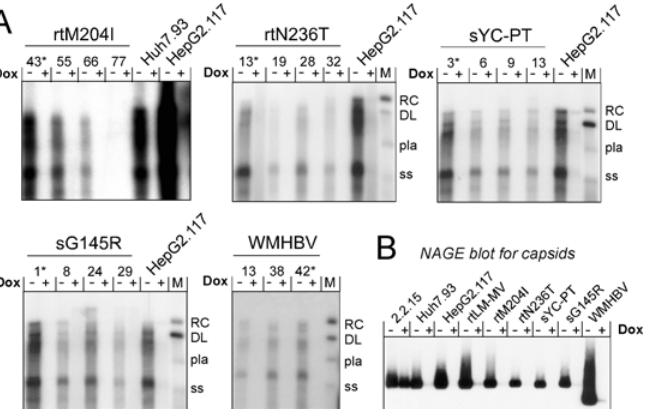
Fig 1. Generation of HepG2-based TetOFF cell lines producing variant HBVs and WMHBV. (A) Selection of well-performing cell clones. Clones preselected for the presence of HBV DNA were grown in the absence (-) or presence (+) of DOX. Intracellular capsid-associated viral DNA was analyzed by Southern blotting, using a 32 P labeled HBV specific probe. The wt-HBV producing Huh7.93 and HepG2.117 lines [44] served as reference. M, marker DNAs consisting of mixture of a 3.2 kb linear HBV genome in double- stranded (DL) and heat-denatured single-stranded (ss) form, plus a 3.2 kb plasmid (pla) including about 500 bp HBV sequence. RC, relaxed circular DNA. Virus variants and individual clone numbers are given on the top, an asterisk indicates the clone used further; sYC-PT is the double-mutant sY100C-P120T. Data for the other cell lines are shown in S1 Fig (B) Verification of DOX-regulation via capsid expression. Equal aliquots of cytoplasmic lysates from the selected cell clones grown without or with DOX were separated